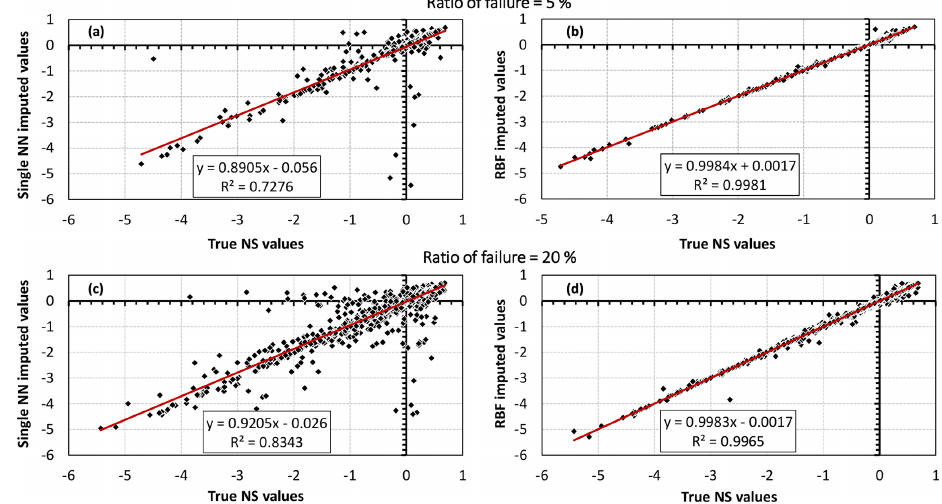
Figure 9. Scatterplots of the true NS values versus the imputed NS values when the ratio of failure was 5% (a, b) and 20% (c, d) for the HBV-SASK model. The accuracy of the crash-handling strategies is demonstrated in panels (a) and (c) for the single NN method and in panels (b) and (d) for the RBF method. These results belong to one arbitrarily chosen replicate out of 50 independent